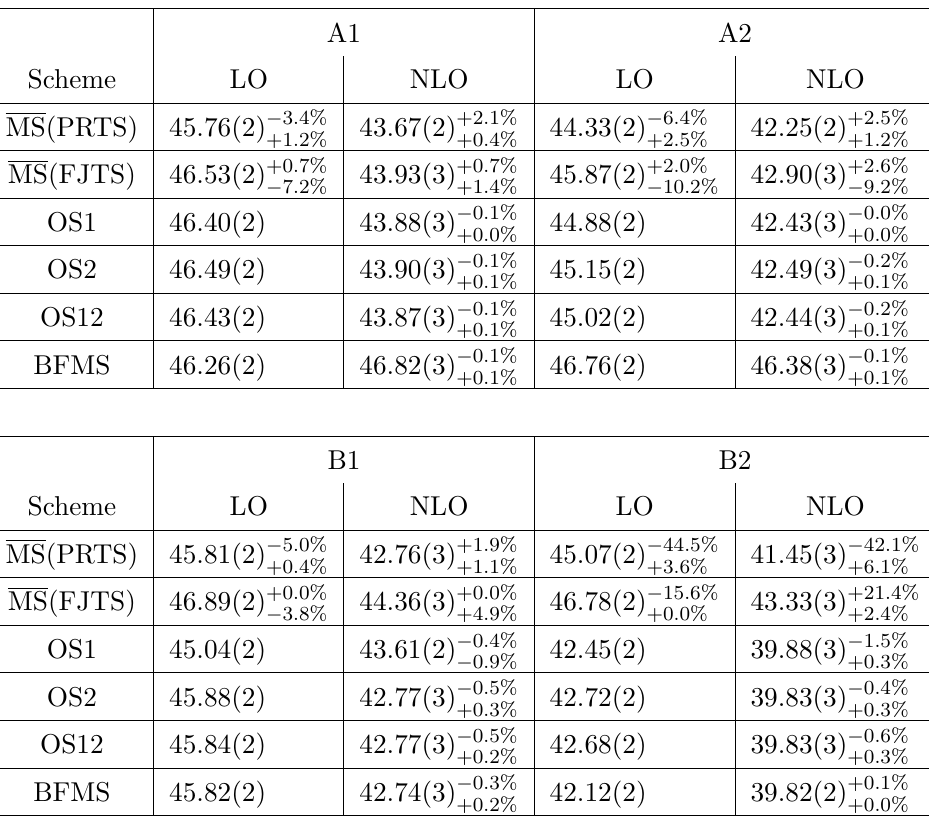
Table 11 . LO and NLO integrated cross sections (cid:27) [pb] for the production of the light Higgs boson in Higgs-strahlung, pp H 2 (cid:22) + (cid:23) (cid:22) + X , for various THDM scenarios in di(cid:11)erent renormalization ! schemes, with the OS12 scheme as input scheme (and full conversion of the input parameters into (cid:22) = 2 (cid:22) 0 with central scale (cid:22) 0 = ( M H + M H + M A + 2 M ) = H + 2 1 0